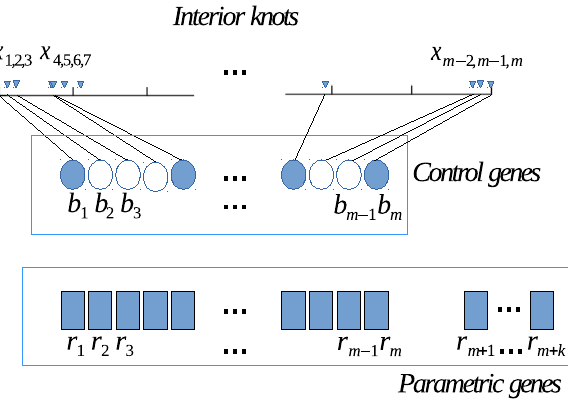
Figure 1. Hierarchical chromosome